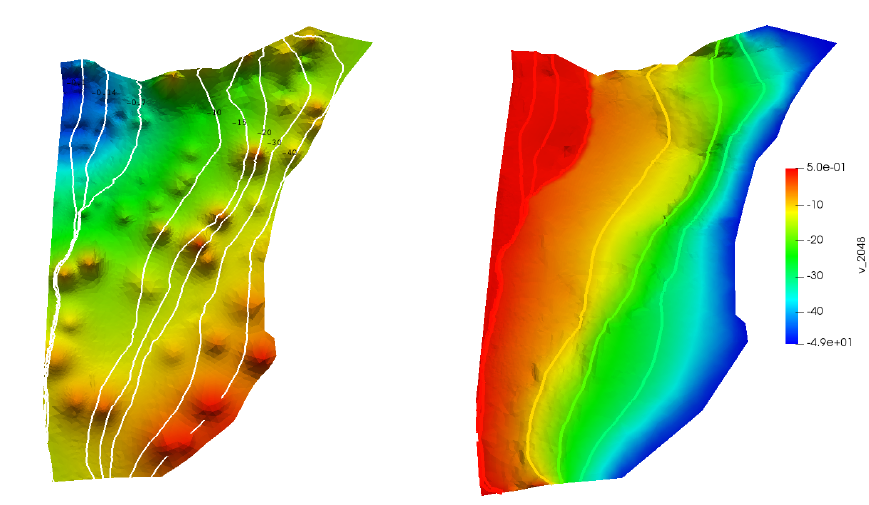
Figure 13. Piezometric contours for saltwater hydraulic heads in